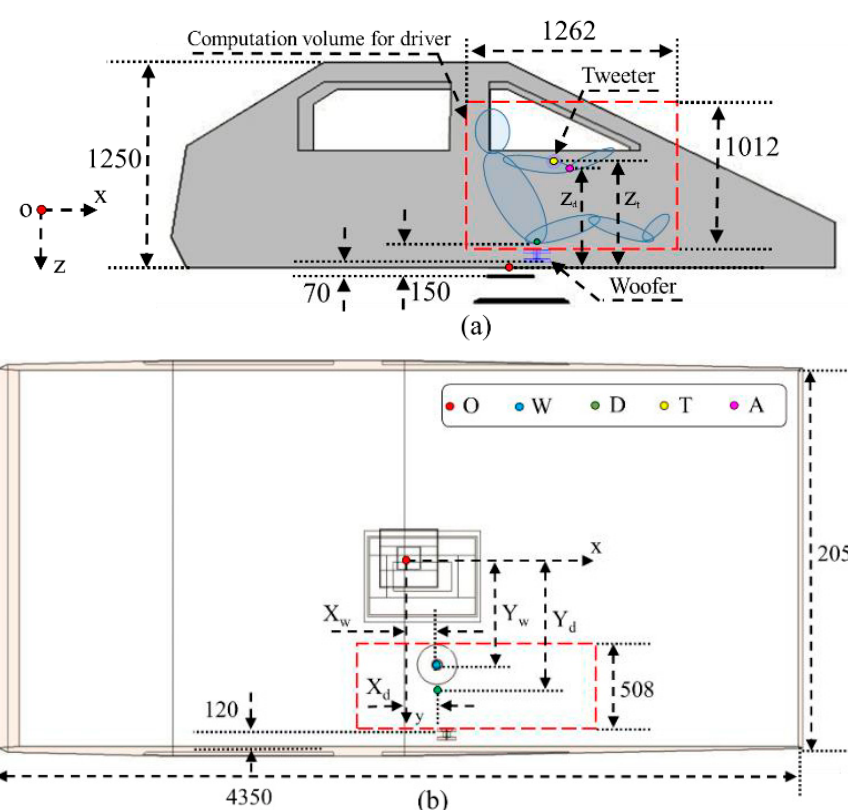
Figure 1. Cross-section of the electric vehicle (EV) model (unit: mm), ( a ) xz plane, ( b ) xy plane (O: origin of coordinate system, W (X w , Y w ): woofer center point, D (X d , Y d ): driver’s buttocks center point, T (X t , Z t ): tweeter center point, A (X a , Z a ): right arm center point).